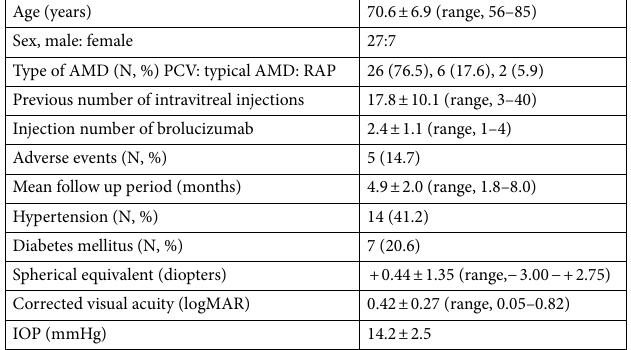
Table 1. Demographic and baseline characteristics (n = 34). Values are presented as N (percentage) or mean ± standard deviation. AMD age-related macular degeneration; PCV polypoidal choroidal vasculopathy; RAP retinal angiomatous proliferation; logMAR logarithm of the minimal angle of resolution; IOP intraocular